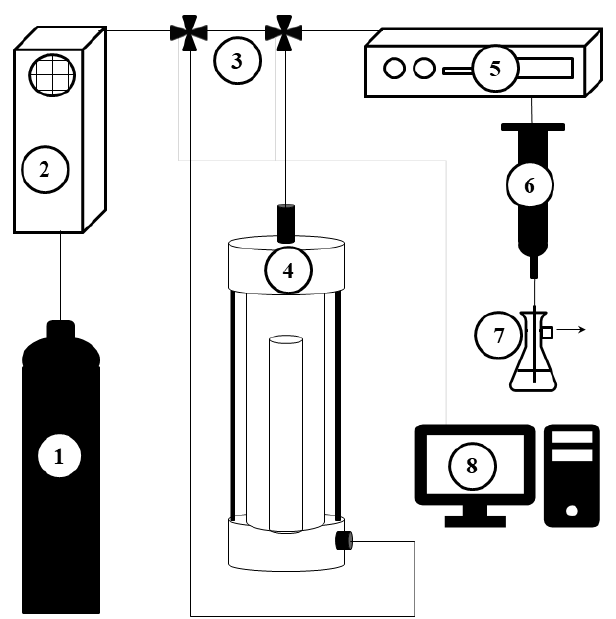
Figure 1. Scheme of the experimental set-up used for ozonation. (1) Oxygen tank, (2) ozone generator, (3) electronic shut-off valves, (4) fixed-bed reactor, (5) on-line ozone monitoring device, (6) ozone destructor, (7) potassium iodide (KI) solution and (8) control and measurement system.